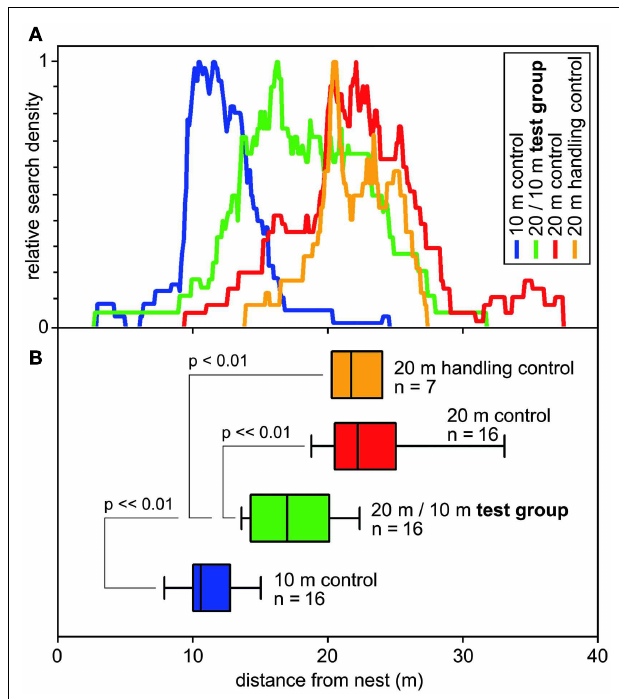
FIGURE 4 | Search behavior of desert ants on their outbound journey, from the nest to the site of a feeder (that was removed for testing). (A) Normalized search densities (no. of visits per 10cm bin of test channel). Color code noted in top right inset. (B) Corresponding box-and-whisker plots (boxes and whiskers as in Figure 2 ); abscissa, distance from the nest. Color code corresponds to (A) ; indicated are numbers of animals and significant differences including significance levels. Medians of the turning points of the food searches of the ant individuals were used to calculate ANOVAs, with pair-wise comparisons according to Holm–Sidak post hoc